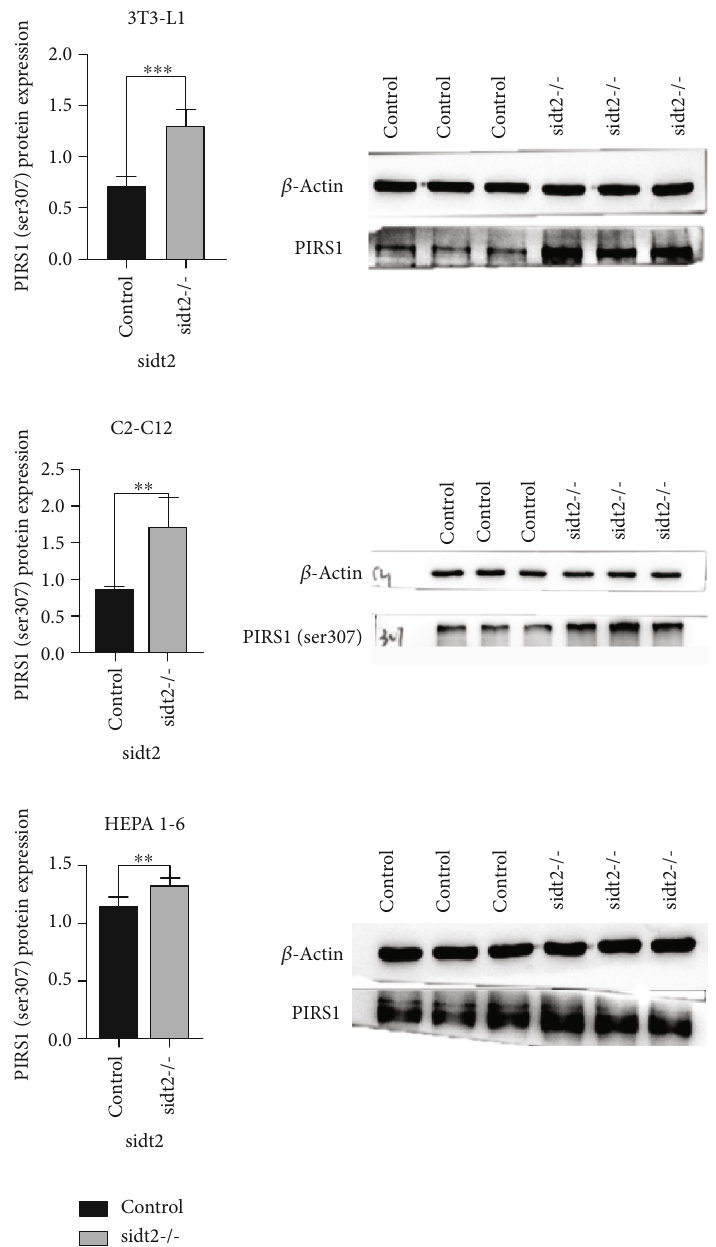
Figure 3: WB results of three cell lines ( ∗ : P < 0 : 05 , ∗∗ : P < 0 : 03 , ∗∗∗ : P < 0 : 01 ). The statistical chart shows that the expression of PIRS1 (ser307) in the sidt2 knockout group is higher than that in the control group, and the di ff erence is signi fi